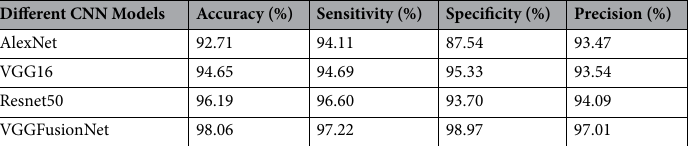
Table 2. Comparative results of different CNN models in terms of accuracy, sensitivity, specificity and